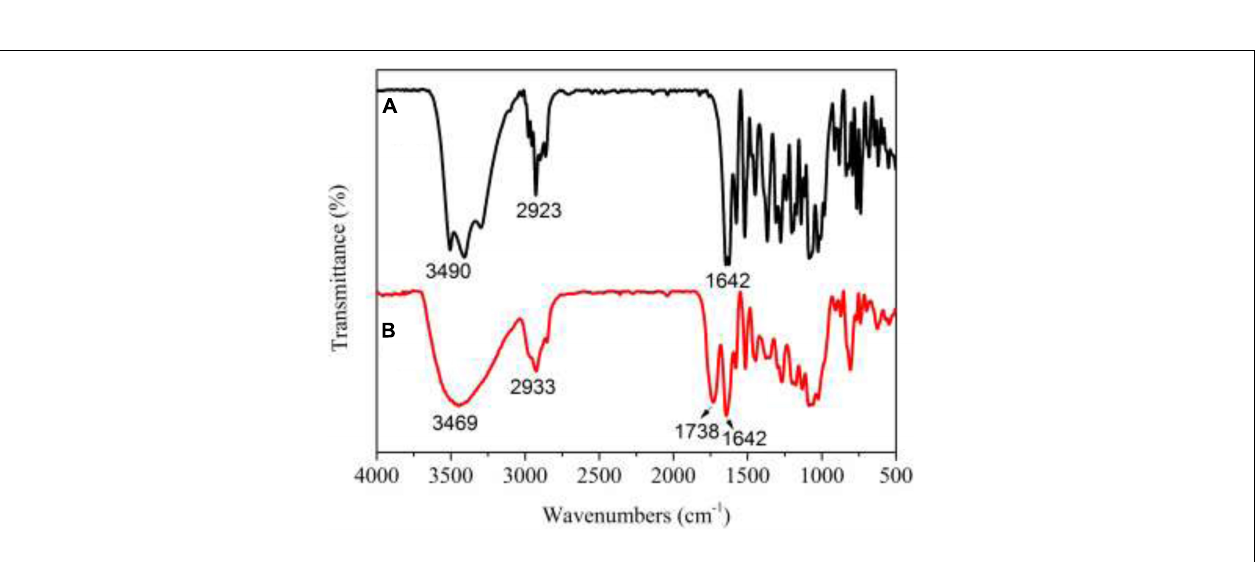
FIGURE 3 | Effects of biocatalyst dosage (A) , substrate mass ratio (B) , temperature (C) , and reaction time (D) on the conversion of NH.